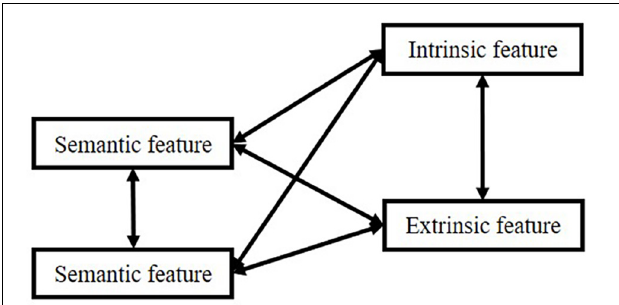
FIGURE 1 | Interactions between items and